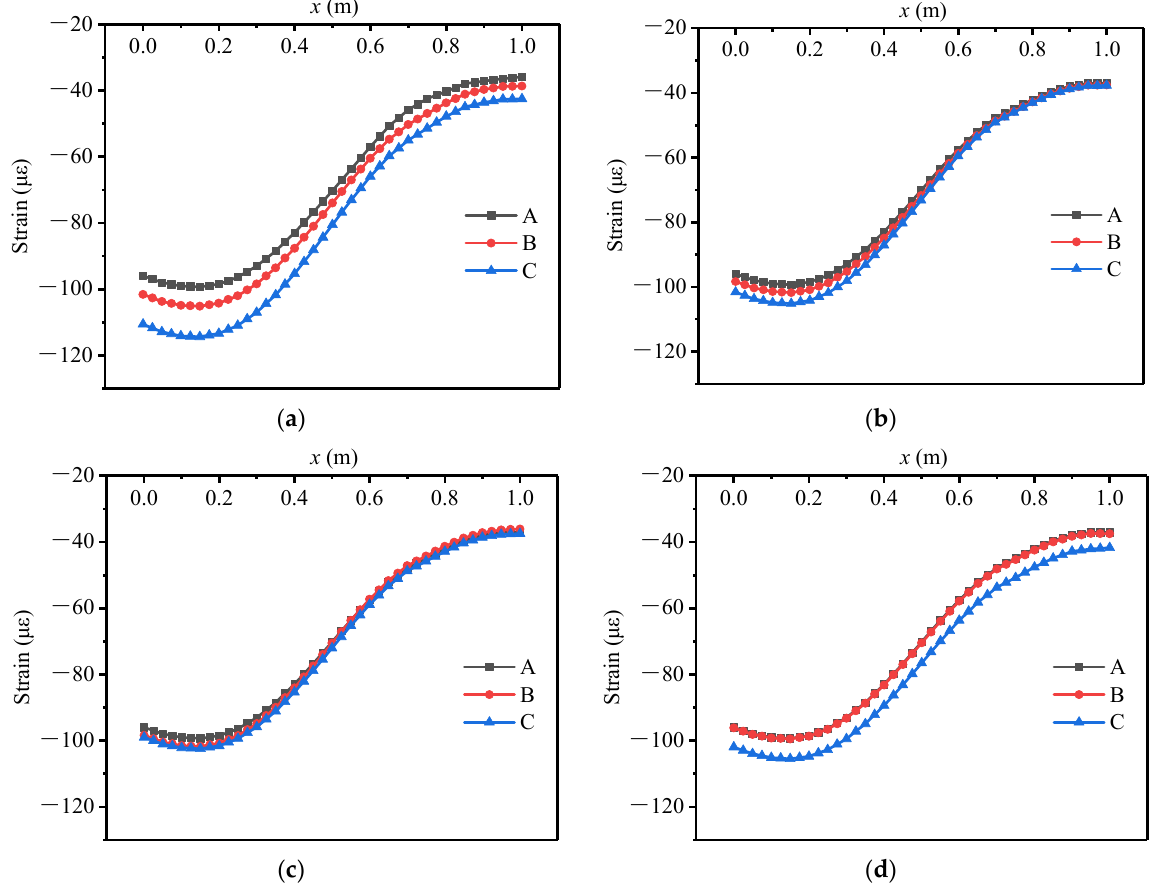
Figure 10. The effects of anisotropy of different materials on the compressive strain on the top of the subgrade: ( a ) Anisotropy in all layers. ( b ) Anisotropy in the HMA layer. ( c ) Anisotropy in the semi-rigid base layer. ( d ) Anisotropy in the subgrade layer.